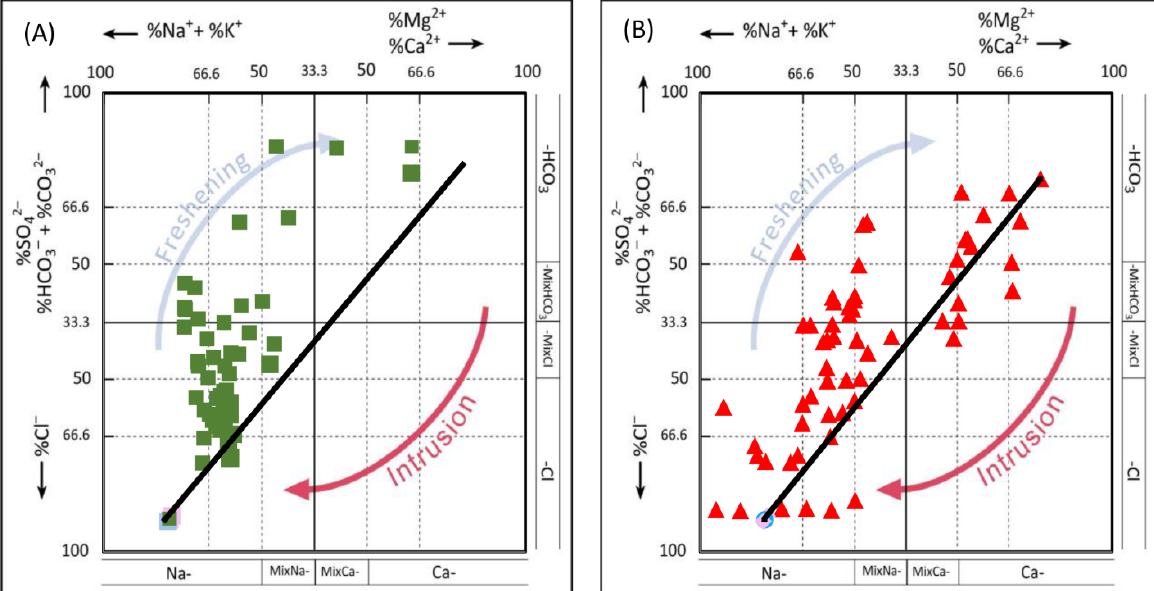
Figure 7. Hydrochemical Facies Evolution diagram of groundwater samples for the ( A ) lower aquifer and ( B ) upper aquifer in southern Benin.